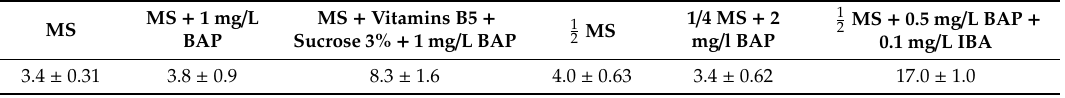
Table 2. Ratio proliferation of shoots of Artemisia hololeuca in a variety of media.